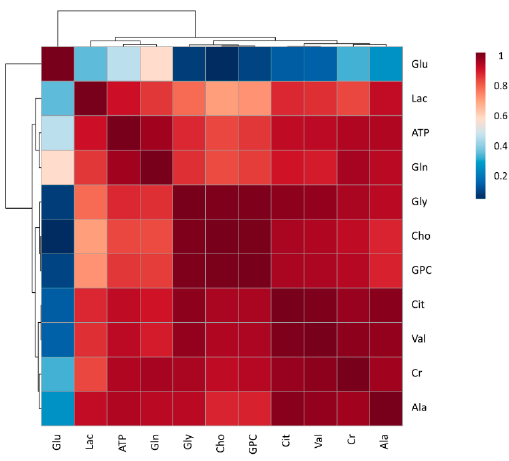
Figure 4. Correlation plot of the eleven analyzed metabolites identified in boar seminal plasma, generated using MetaboAnalyst. The color saturation of red to blue represents the Pearson correlation coefficients (r) between metabolites, from 0 to 1, respectively. Adenosine Triphosphate (ATP), Alanine (Ala), Choline (Cho), Citrate (Cit), Creatinine (Cr), Glutamic acid (Glu), Glutamine (Gln), Glycine (Gly), Glycerophosphocholine (GPC), Lactate (Lac) and Valine (Val).